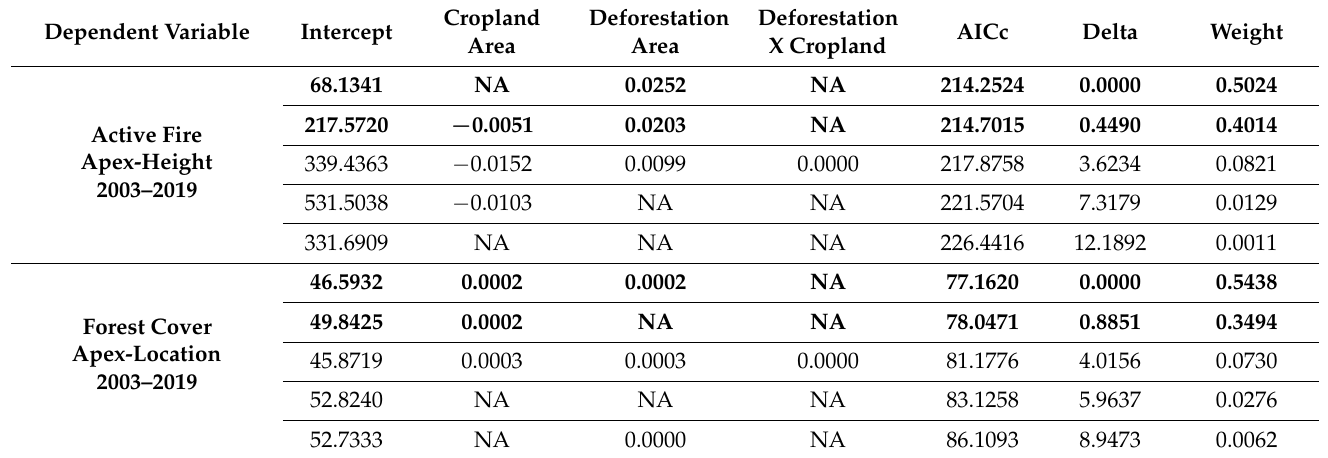
Table A2. Predicted models for the active fire apex-height and forest cover apex-location models. These analyses considered deforestation rates and cropland area as independent variables. In these models, we considered soybean and temporary crops as cropland area. The results are ranked by the AIC of each